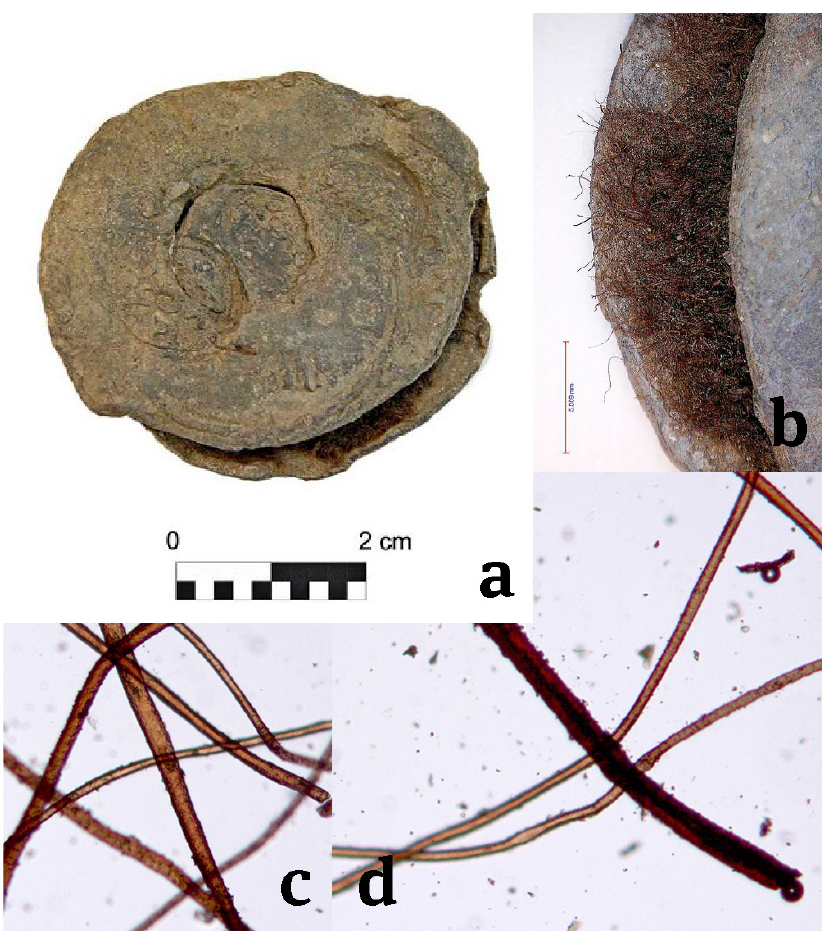
Figure 21. Textile remnants attached to the seal from Wschowa: a – seal, b – the fabric shown in x150 magnification (micro- scope Zeiss SteREO); c and d – the fibres shown in x500 magnification (microscope Zeiss Axio Scope